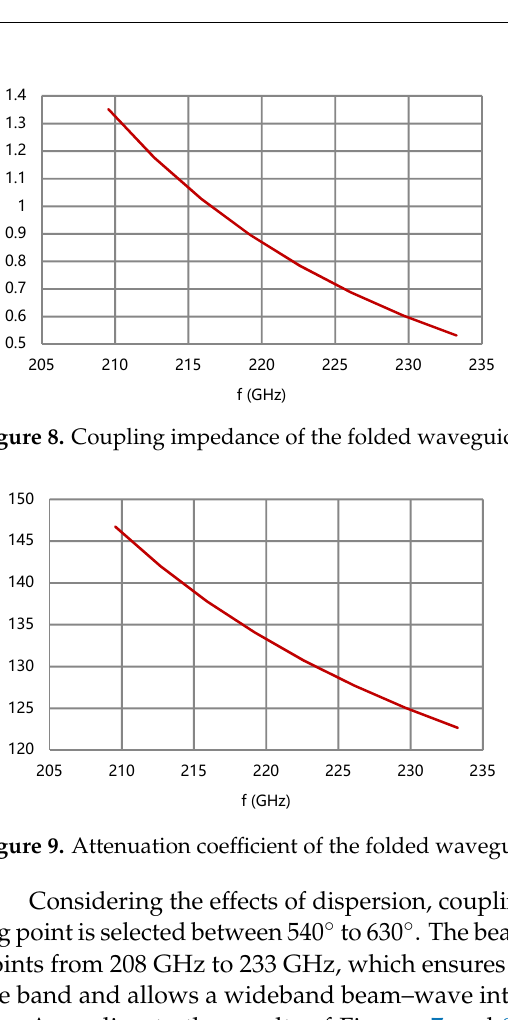
Figure 7. Normalized phase velocity of the folded waveguide circuit.